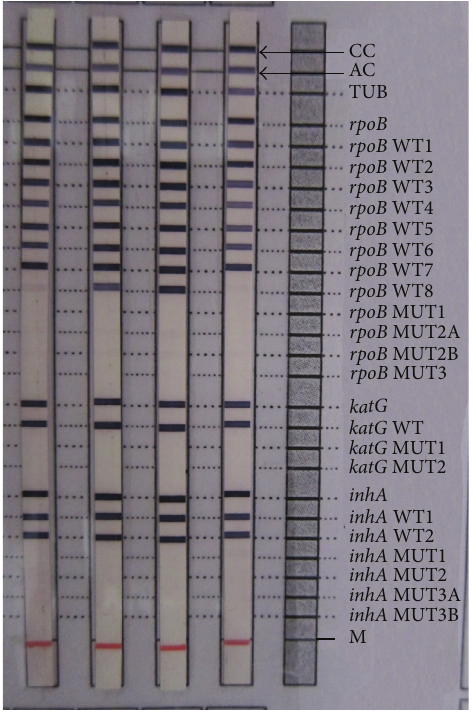
Figure 6: (From left to right) Lane 1: faint rpoB WT8 band interpretedassensitivepattern.Lanes2and3:sensitivepattern.Lane 4: sensitive pattern with absent rpoB WT8 band.